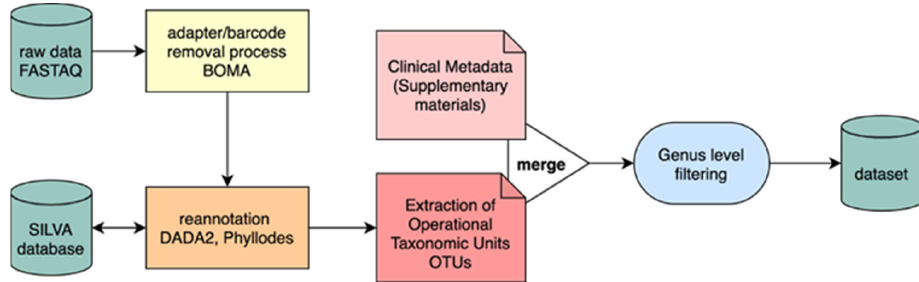
Figure 1. Data preprocessing and transformation.